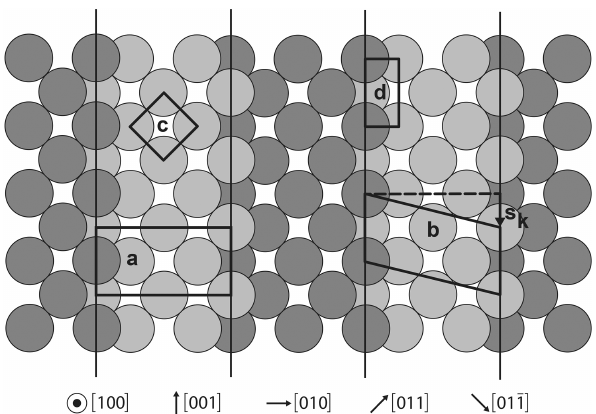
Figure 4. Schematic drawing of a copper (410) face. Label a: pro- √ ×√ jection of (2 2 2 ) R45 ◦ –O–Cu(100) cell; b: step atom cell, √ ×√ showing the relation with (2 2 2)R45 ◦ cell, for which s k is the step vector which acts as a stacking fault; c: cell of (100) two- dimensional (2D) lattice; d: step site, here equivalent to a cell of (110) 2D